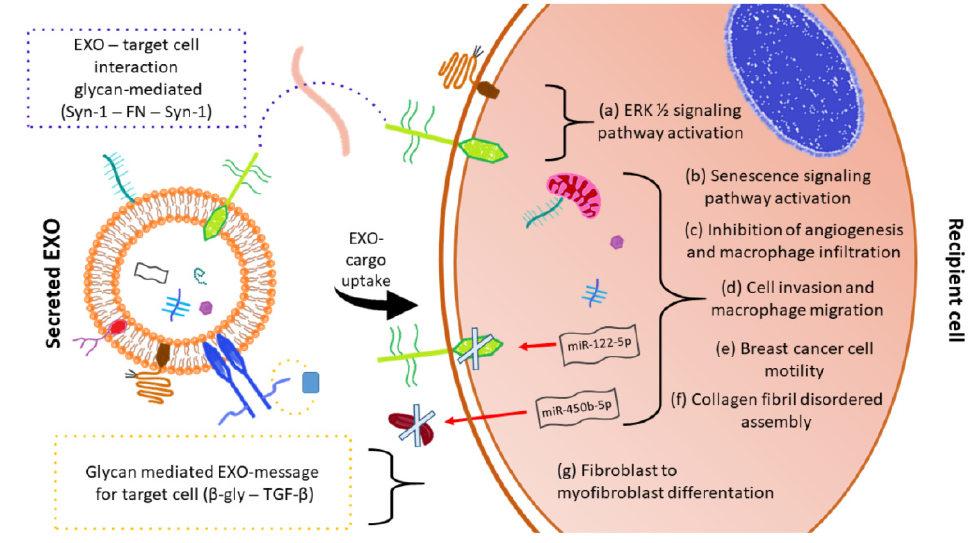
Figure 2. Glycans impact on EXO cell targeting and molecular pathway modulation. Graphical sketch of the reported glycans and miRNAs involved in: ( a ) EXO–target cell interaction mediated by fibronectin (FN) as a key syndecan-1-ligand [59], or by syndecan and glypican as internalizing receptors and ERK ½ signaling activators [58]; ( b ) the induction of cellular senescence due to versican targeting of recipient cell mitochondria [63]; ( c ) endostatin antiangiogenic and anti macrophage infiltration activity [53]; ( d ) increase of cell invasive phenotype and macrophages migration as the effect of EXO-serglycin uptake [62]; ( e ) induction of breast cancer cell motility by syndecan-1 down-regulation (EXO-miR-122-5p induced) [60]; ( f ) collagen fibril disordered assembly by ECM lumican down-regulation (EXO-miR-450b-5p induced) [64]; ( g ) TGF- β delivery in recipient cell through EXO surface–betaglycan interaction, determining fibroblast differentiation into myofibroblast [61]. (Syn-1, syndecan-1; β -gly, β -glycan).